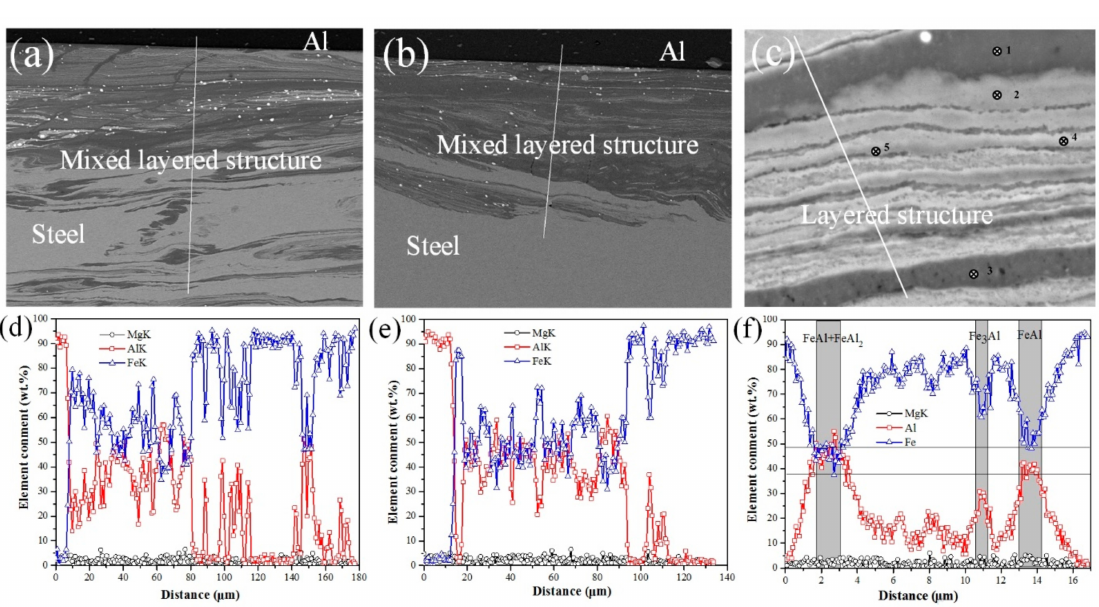
Figure 11. Scanning electron microscopy (SEM) line scanning results. ( a ) macrostructure of the interface at the center of the joint; ( b ) macrostructure of the interface on retreating side of the joint; ( c ) the layered structure at the interface; and ( d – f ) the line scan